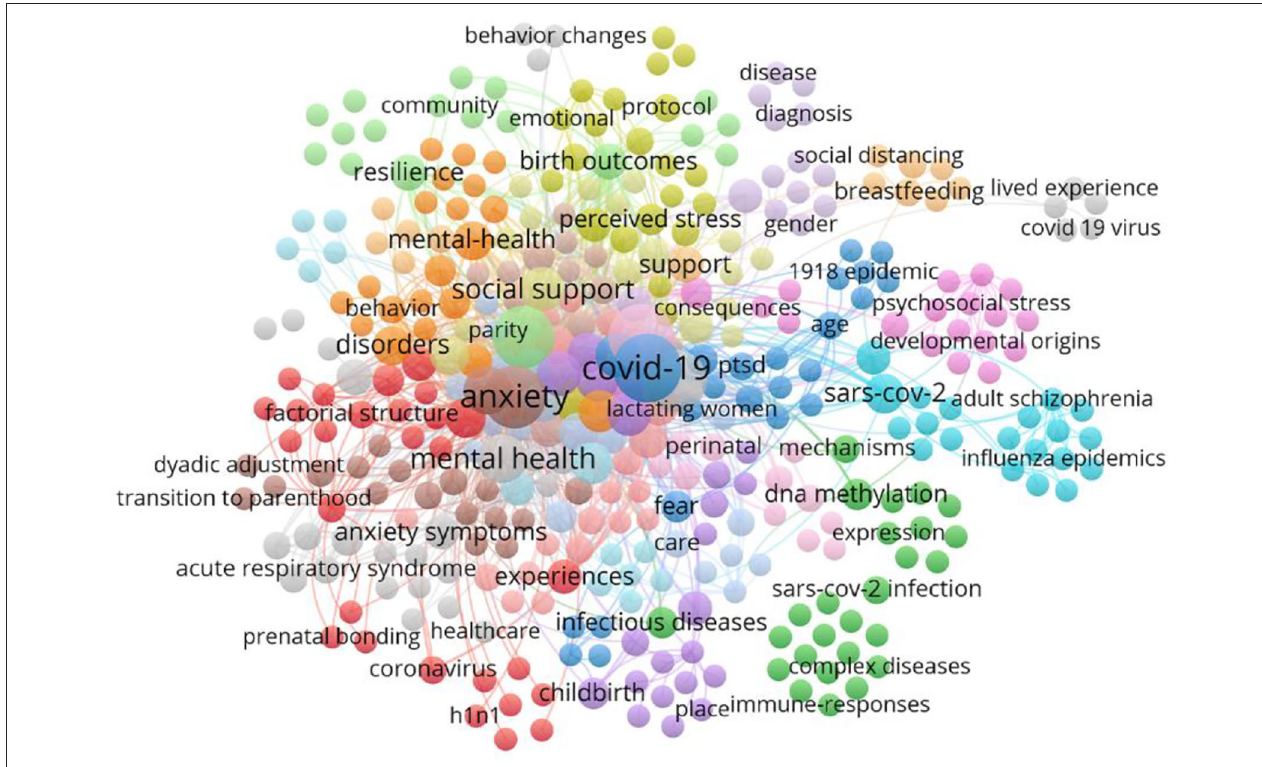
FIGURE 9 | Network of keywords of PS caused by COVID-19, and 367 keywords are divided into 22 categories according to different colors. The size of the node indicates the frequency of occurrence.